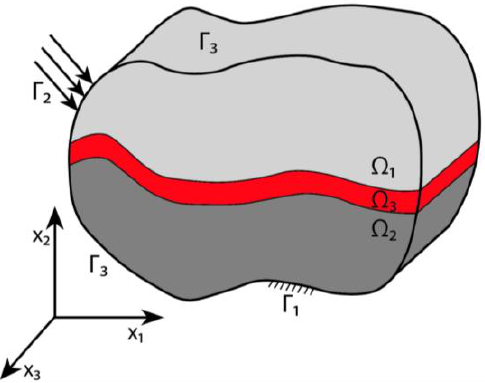
Figure 1. Computational model of a three-layer mechanical package.